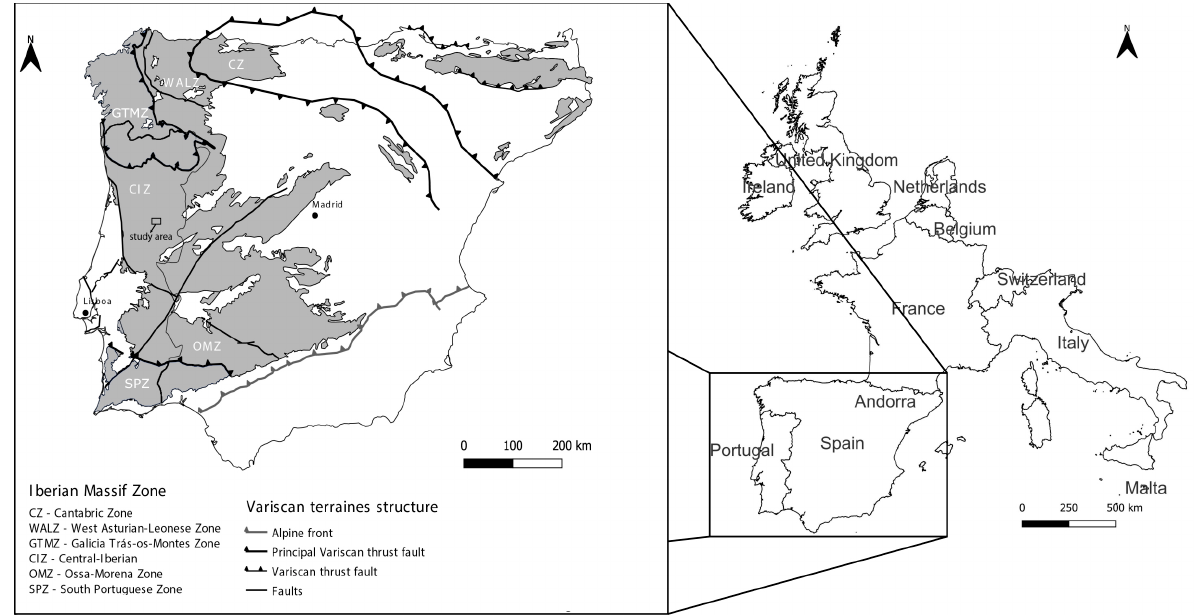
Figure 1. Location of the studied area in the autochthonous terrains of the Central-Iberian Zone (CIZ) and framework in Southern and Western Europe.